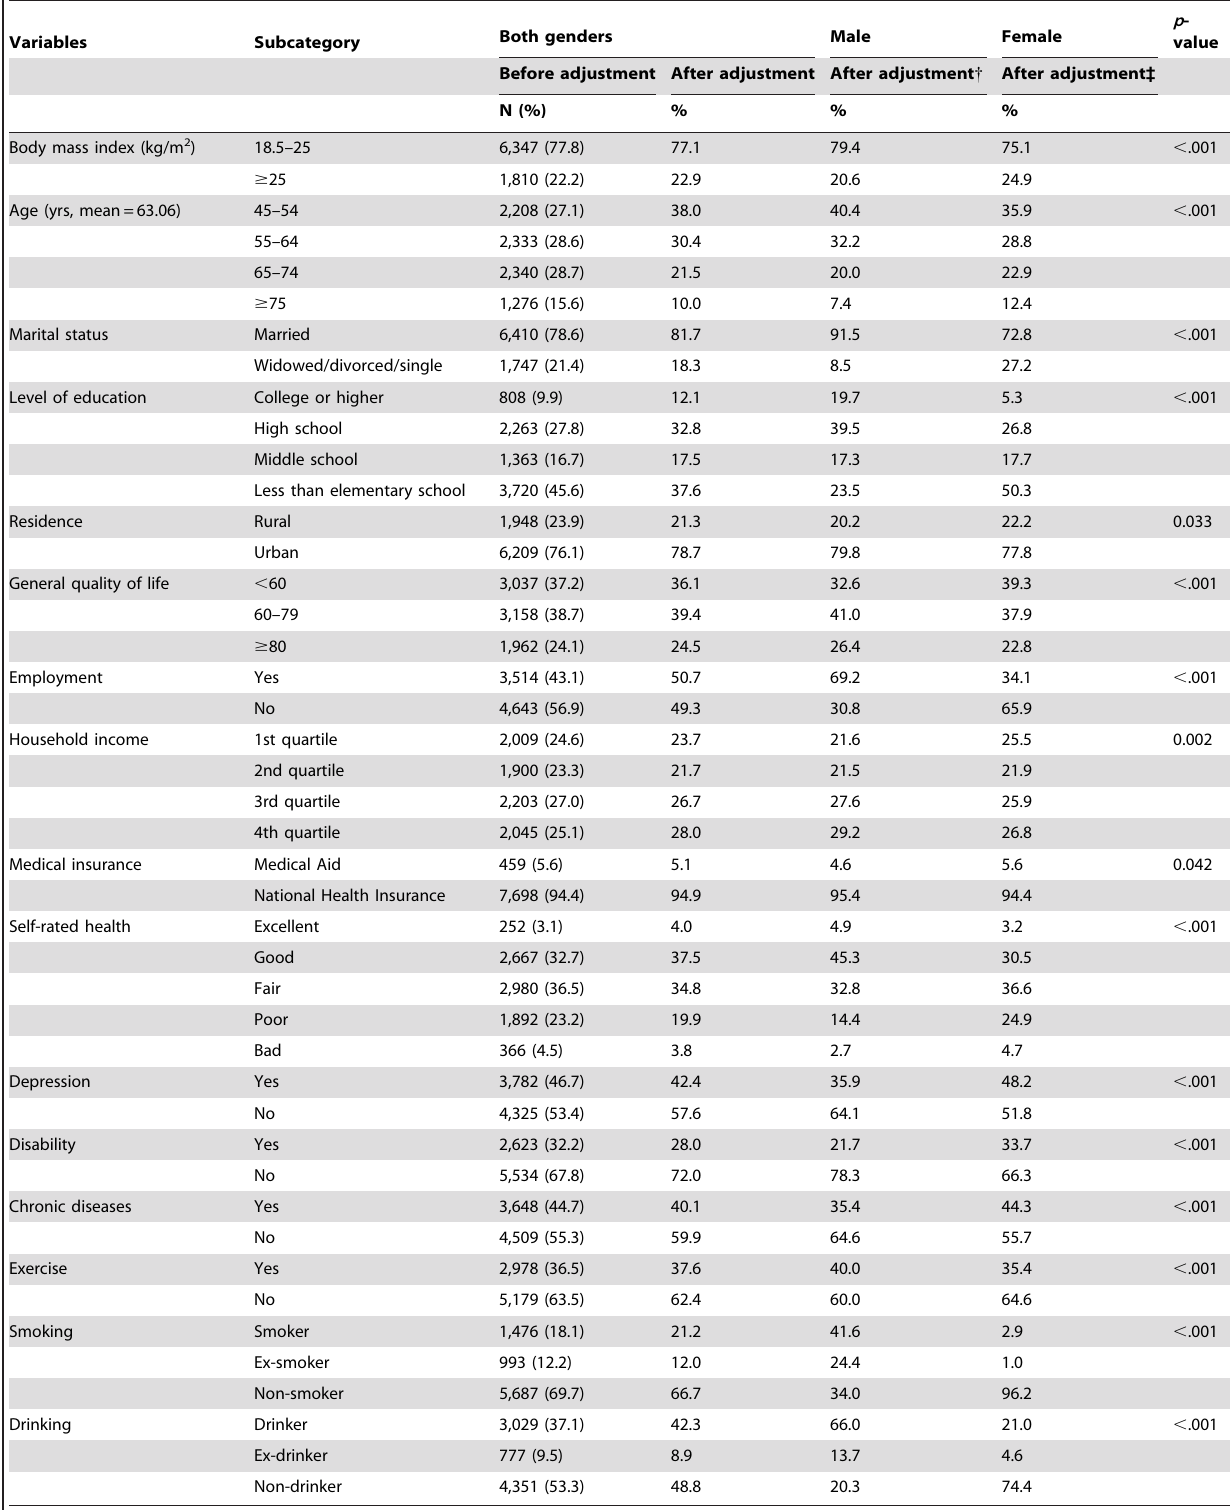
Table 1. Characteristics of the study population (n=8,157), Korea, 2008*.